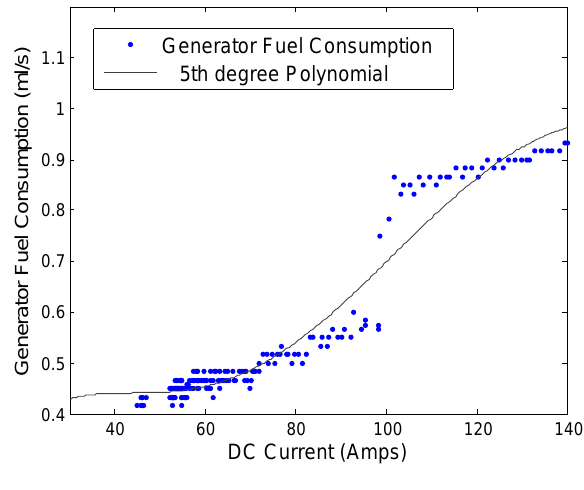
Figure 3. DC generator fuel consumption